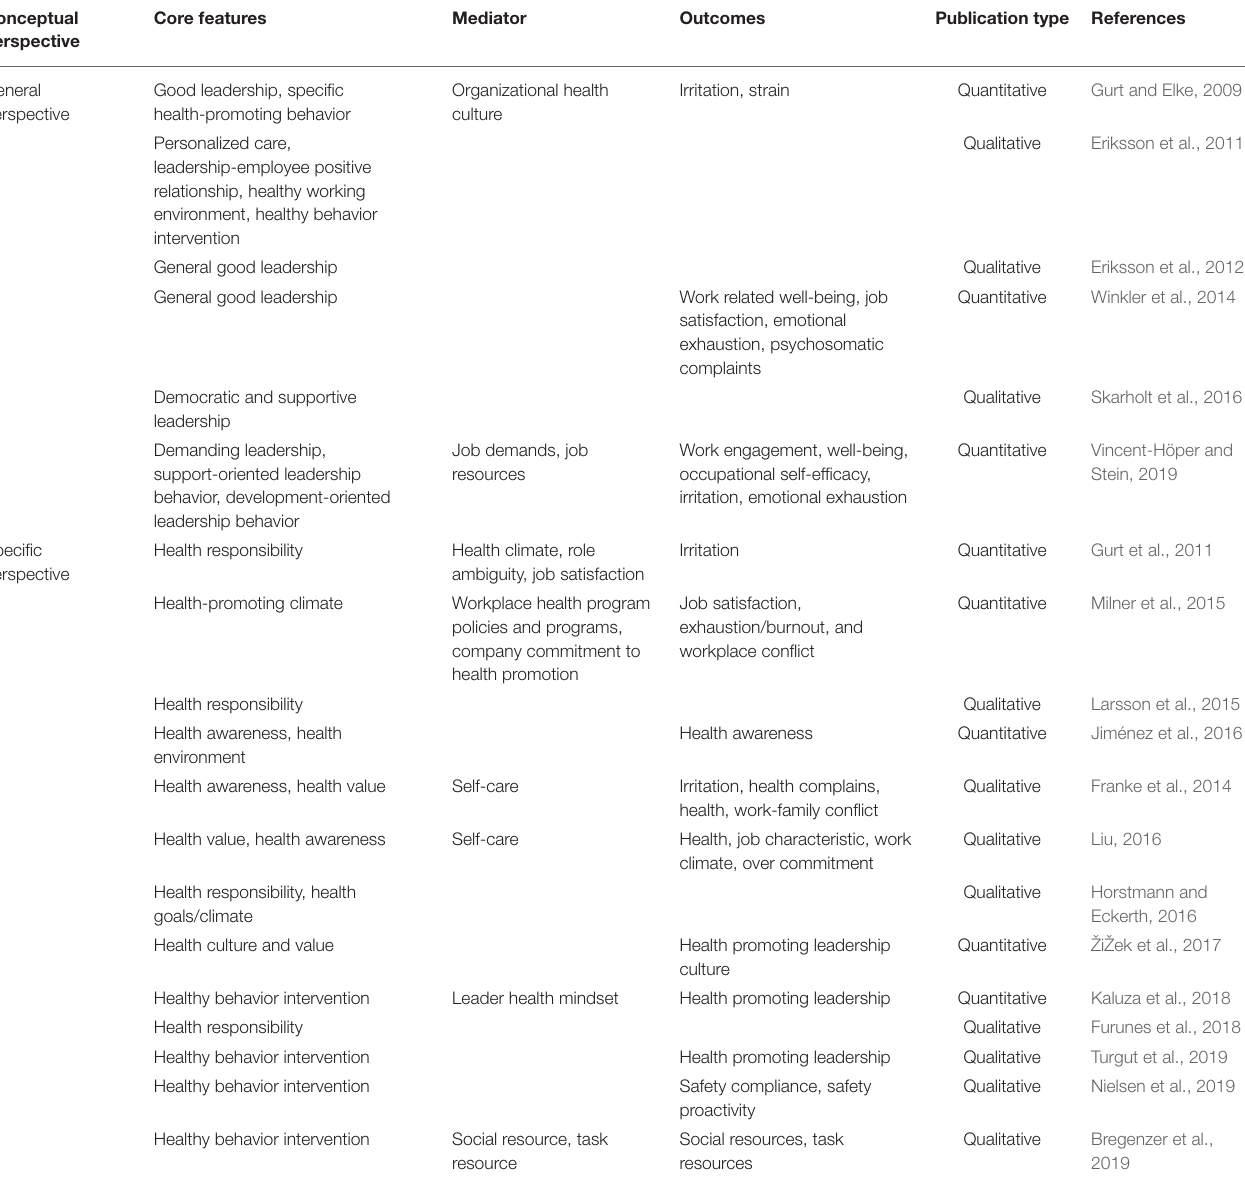
TABLE 1 | Summary of health promoting